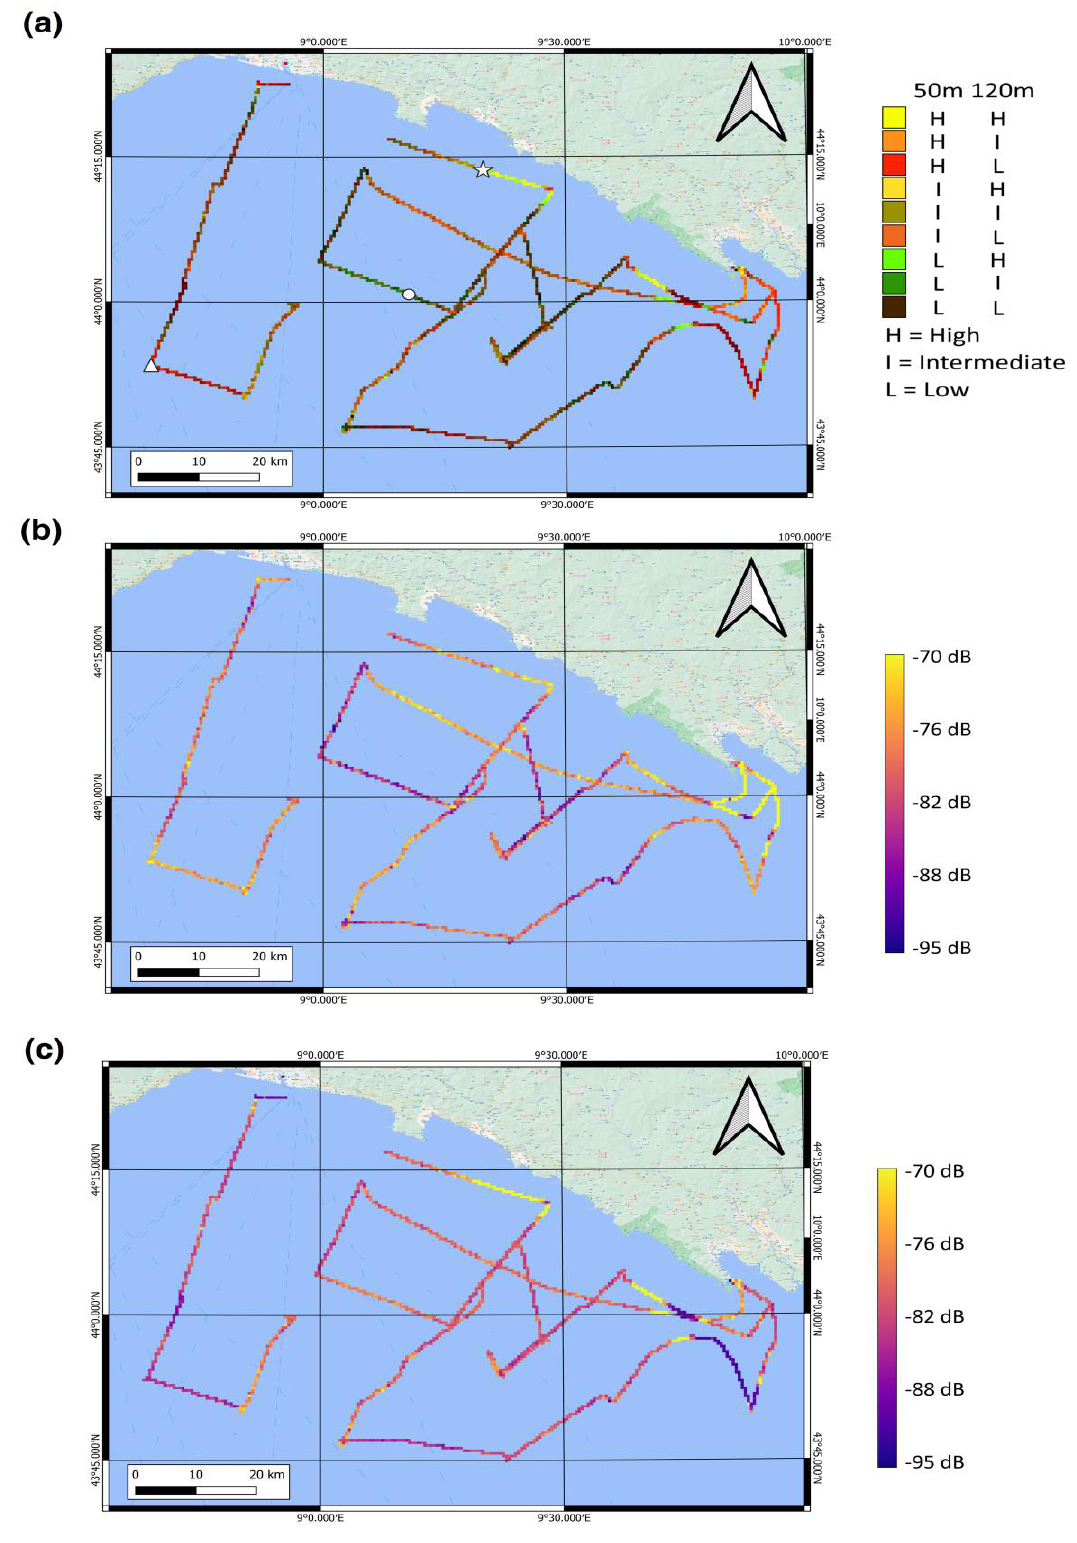
Figure 7. Results from false color composition tested on 2017 Campaign data. ( a ) False color representation using the color-scale associated with the different cases of the defined metrics. White markers indicate the position of the selected profiles reported in Figure 8. ( b ) The associated backscatter values at depths of 50 m and ( c ) at 120 m.